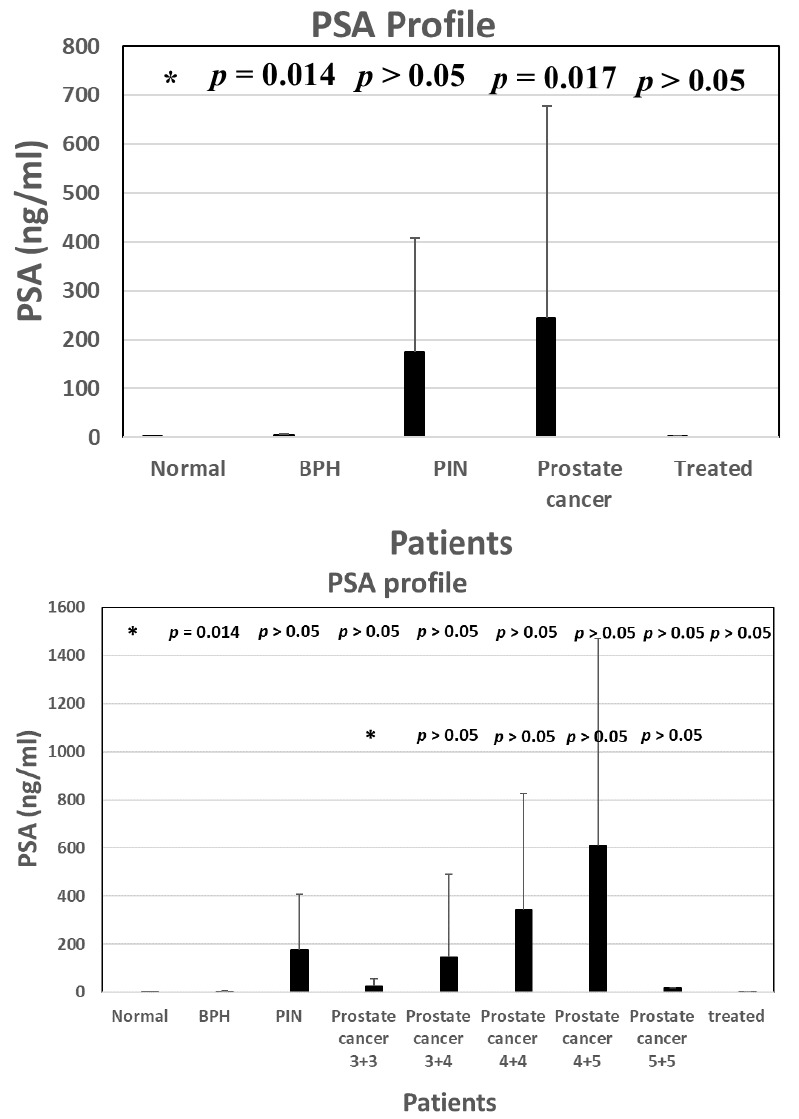
Figure 9. PSA levels in normal individuals and patients of BPH, PIN, and prostate cancer and treated prostate cancer patients. The numbers (3 + 3 etc.,) under each category of prostate cancer are Gleason scores. ”*” is the reference data for statistical analysis.